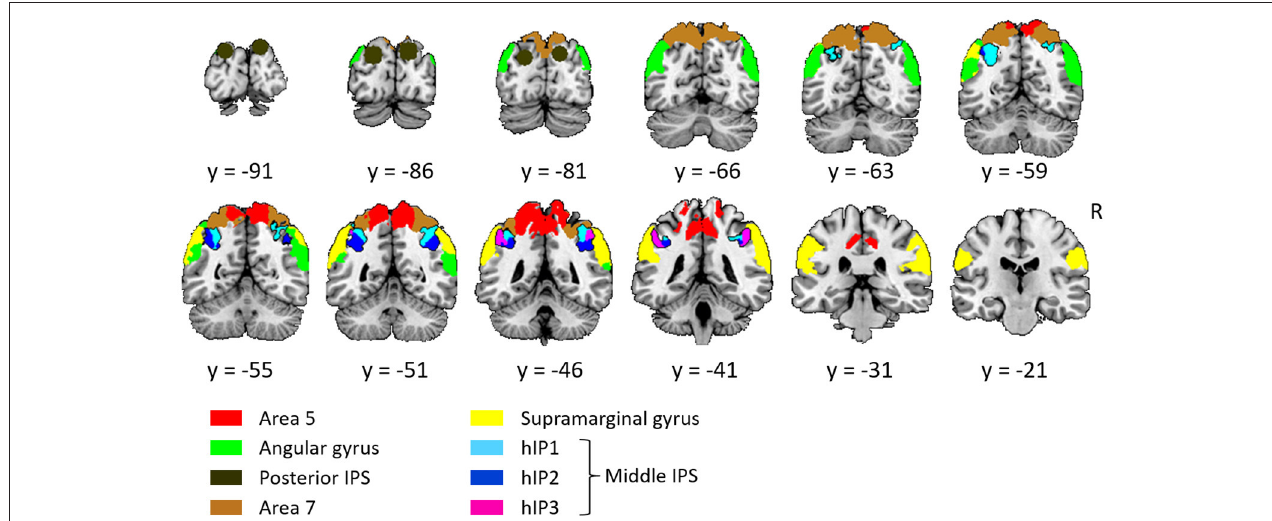
FIGURE 2 | Overview of all volumes of interest. The primary focus was on middle IPS (sum of hIP1, hIP2, and hIP3), the other VOIs served as comparison. Except from posterior IPS, all VOIs were extracted from the Jülich-Düsseldorf cytoarchitectonic atlas by means of the Anatomy Toolbox ( Eickhoff et al., 2005). The angular gyrus corresponds to the summation of area PGp and PGa; the supramarginal gyrus to area PFt, PFop, PFcm, PF, and PFm; area 5 to 5L, 5M, and 5Ci; area 7 to 7A, 7P, 7M, and 7PC. Posterior IPS VOIs was based on previously published fMRI MNI group coordinates (15, − 87, 33 and − 21, − 87, 30; Vandenberghe et al., 2005).